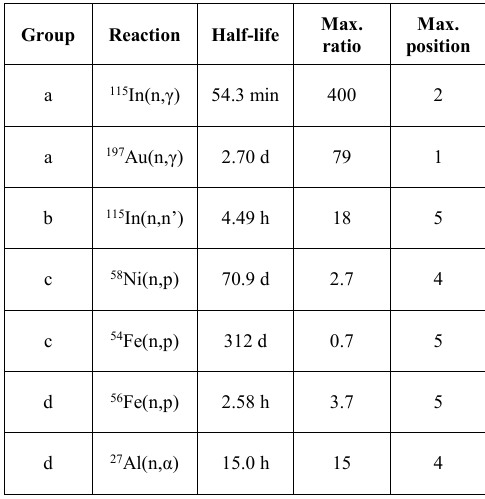
Table 1. Reactions of interest for all transmission experiments, with propagation results in the case of the natural iron reflector. The reactions are sorted by neutron energy range and group of interest, as defined in Section 3.2. The maximum ratios of reaction rate distribution over activity uncertainty are indicated, as well as the associated dosimeter positions in the